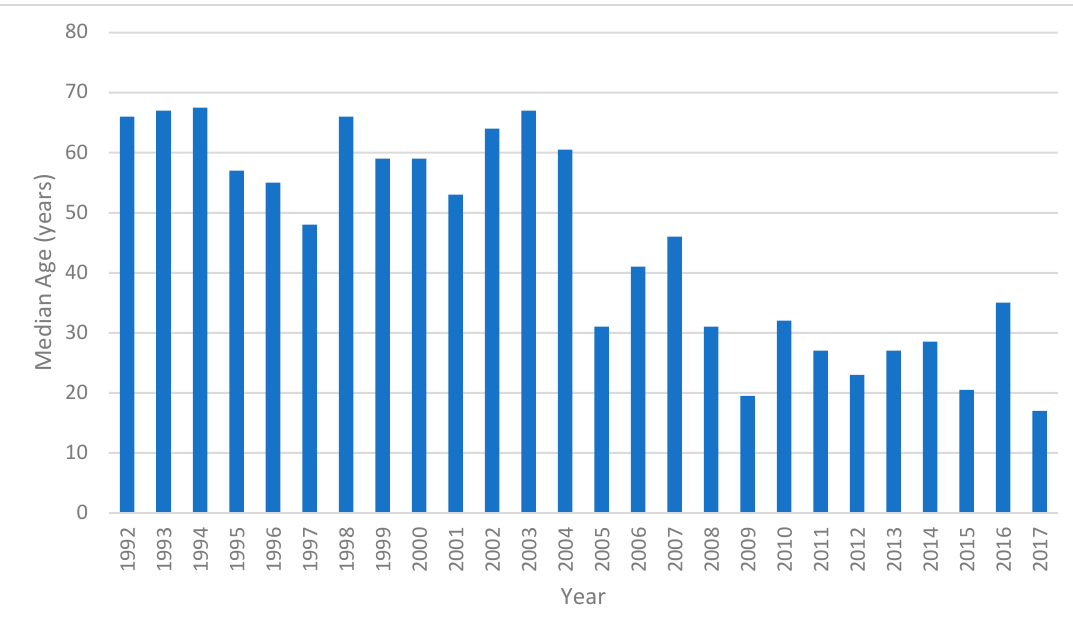
Figure 1. Number of cases and rate per 100,000 population of notified tuberculosis (TB) cases between 1992 and 2017.